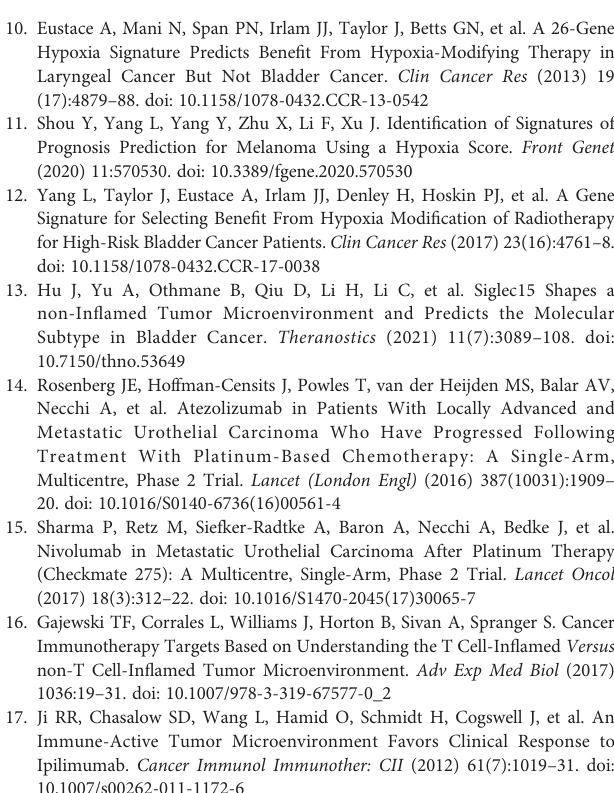
Supplementary Figure 11 | Hypoxia risk score correlated with immune characters of TME and predicted the clinical response of ICB in the younger subgroup in TCGA-BLCA. (A) Differences in activities of the cancer immunity cycles between high- and low-risk scoregroups. (B) Thecorrelations between the hypoxia risk score and several immune cells. (C) The correlations between the hypoxia risk score and T cell in fl amed score (TIS). (D) The correlations between hypoxia risk score and the enrichment scores of immunotherapy-predicted pathways. (E) The correlations between hypoxia risk score and immune checkpoints. Supplementary Figure 12 | Roles of hypoxia risk score in the GSE13507. (A) Correlations between hypoxia risk score and the activities of the cancer immunity cycles. (B) Correlations between hypoxia risk score and the enrichment scores of immunotherapy-predicted pathways. (C) Correlations between hypoxia risk score and immune checkpoints. (D) Correlations between hypoxia risk score and genes of the T cell in fl amed score algorithm. (E) The associations between the hypoxia risk score groups and the molecular subtypes in seven different algorithms. (F) The predictive accuracy of hypoxia risk score for molecular subtypes in seven different algorithms. (G) Correlations between hypoxia risk score and the enrichment scores of several therapeutic signatures such as targeted therapies and radiotherapy. Supplementary Figure 13 | Roles of hypoxia risk score in the GSE32894. (A) Correlations between hypoxia risk score and the activities of the cancer immunity cycles. (B) Correlations between hypoxia risk score and the enrichment scores of immunotherapy-predicted pathways. (C) Correlations between hypoxia riskscoreandimmunecheckpoints. (D) Correlationsbetweenhypoxiarisscoreand genes of the T cell in fl amed score algorithm. (E) The associations between the hypoxia risk score groups and the molecular subtypes in seven different algorithms. (F) The predictive accuracy of hypoxia risk score for molecular subtypes in seven different algorithms. (G) Correlations between hypoxia risk score and the enrichment scores of several therapeutic signatures such as targeted therapies and